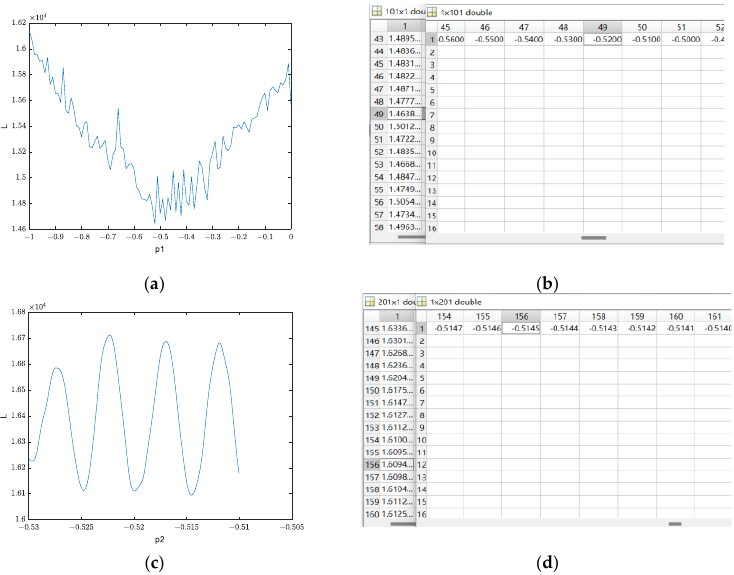
Figure 7. Change of mixed-signal sparsity of the first receiving channel with order. ( a , b ) Rough search result; ( c , d ) Exact search result.